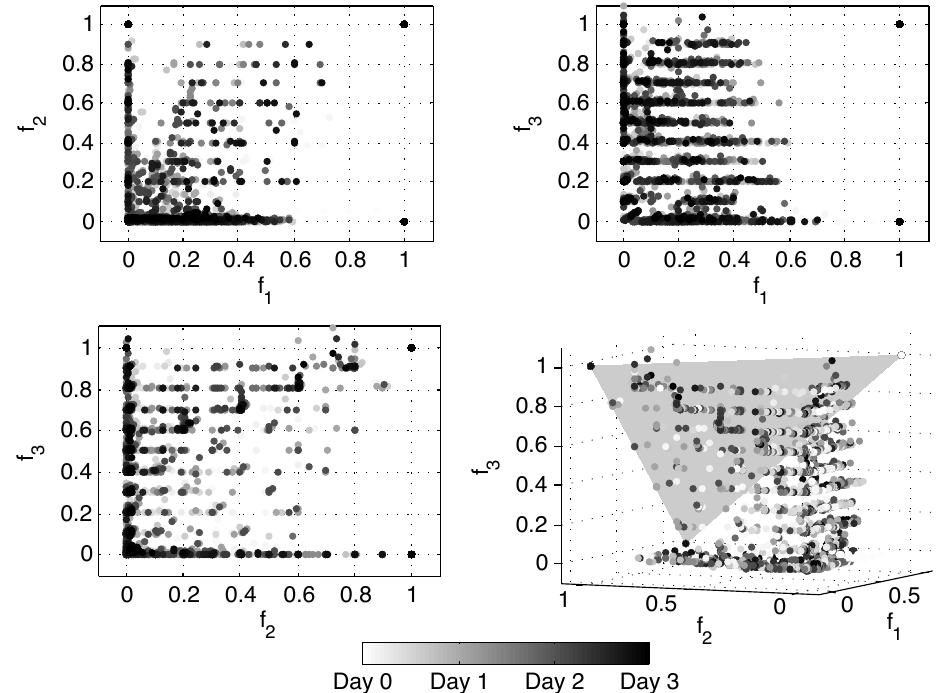
Figure 5. Pareto front over the normalized design space calculated with the ENNCP